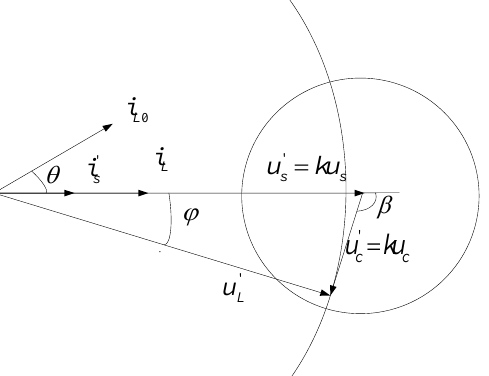
Energies 2022 , 15 , x FOR PEER REVIEW 11 of 23 Figure 8. Schematic diagram of composite control vector at secondary side. Figure 8. Schematic diagram of composite control vector at secondary side.